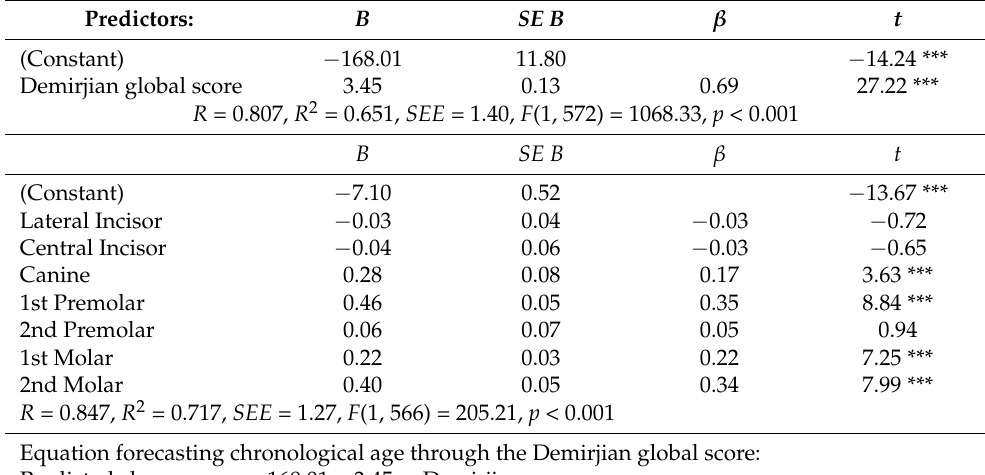
Table 2. Simple regression analysis of chronological age predicted by the Demirjian global score and tooth by tooth ( n =